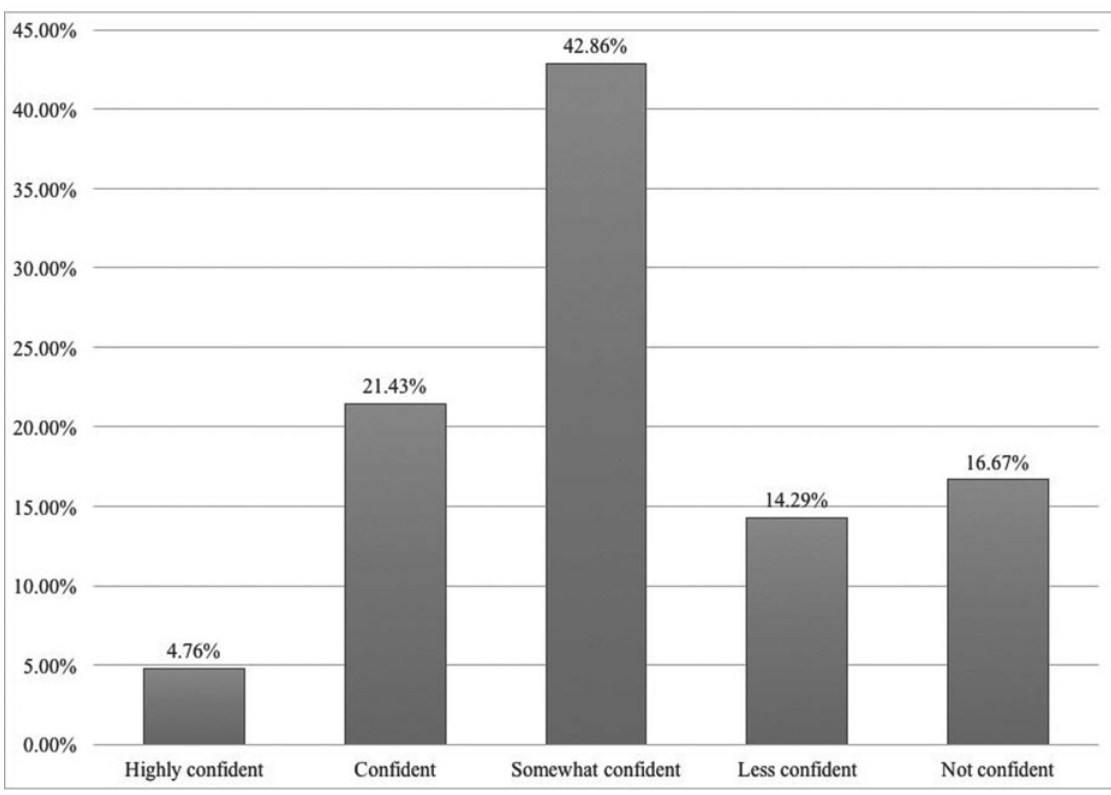
FIGURE 4 Confidence in the fairness of electoral